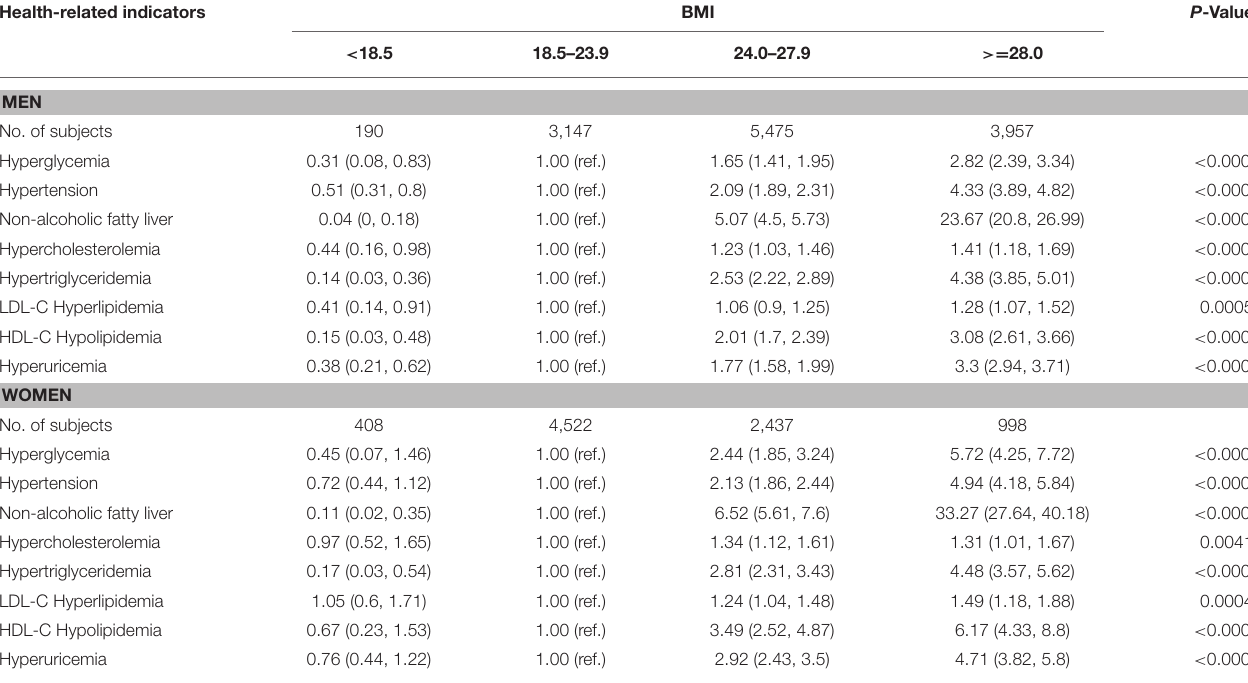
TABLE 3 | Age- and history of diseases-adjusted odds ratios with 95% confidence interval for the association between BMI and health-related indicators stratified by sex a . Health-related